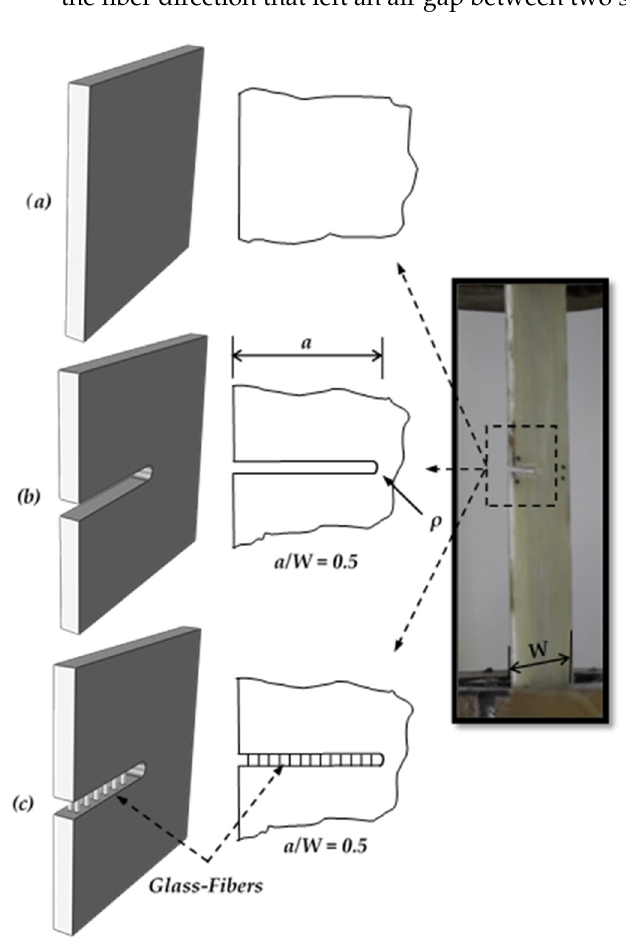
Figure 1. Types of cracks, ( a ) smooth (crack free), ( b ) through thickness crack, and ( c ) matrix crack.